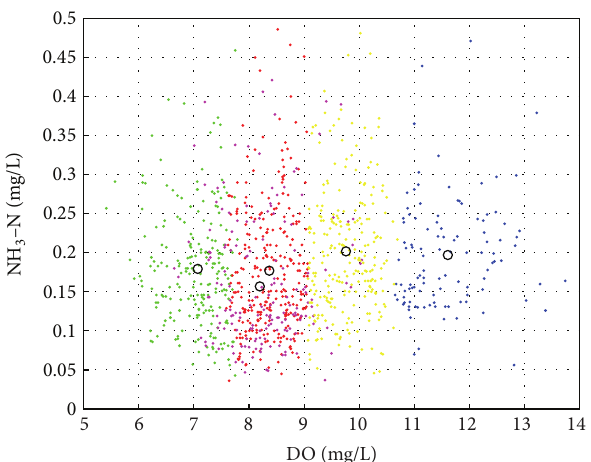
Figure 5: The distribution of water quality under the influence of DO and NH 3 –N.